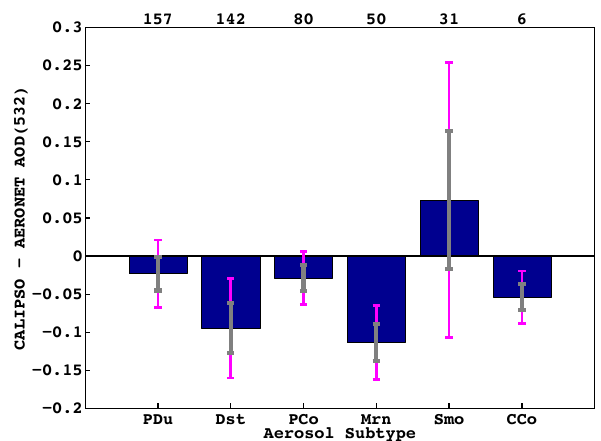
Fig. 4. Absolute bias with 67% and 95% confidence intervals for 515 overpasses with a single CALIPSO aerosol subtype through- out the column. CALIPSO aerosol subtypes include polluted dust (PDu), dust (Dst), polluted continental (PCo), marine (Mrn), smoke (Smo), and clean continental (CCo). Number of overpasses per sub- type are indicated by the top row of numbers.